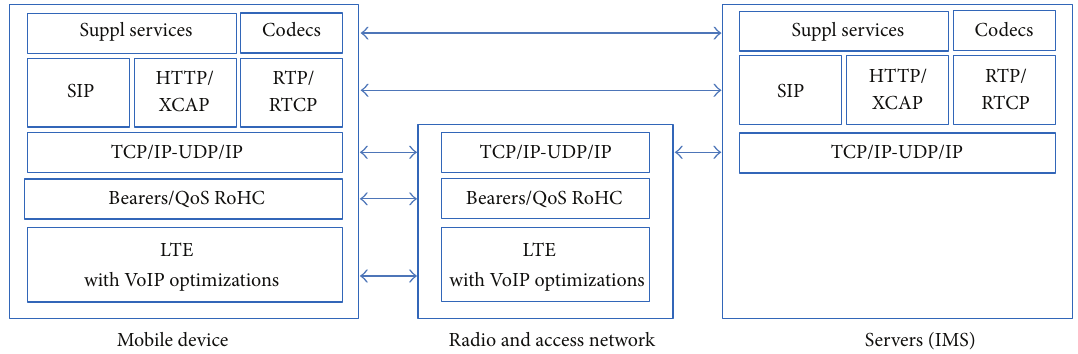
Figure 1: Scope of VoIP deployment over LTE by GSMA PRD IR.92